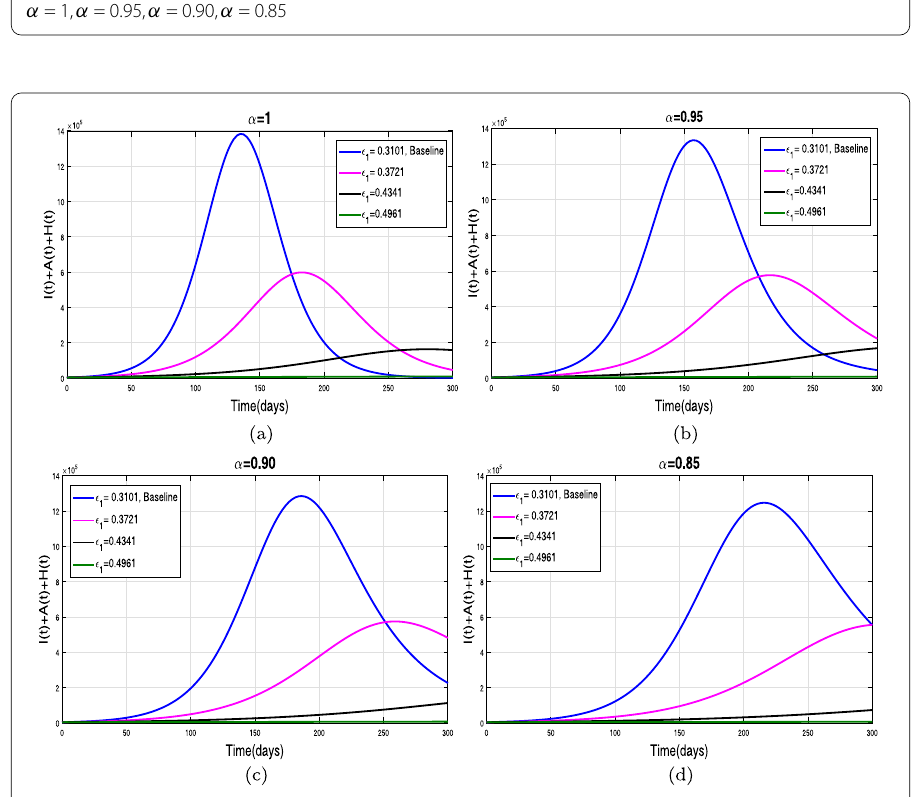
Figure 5 The influence of quarantine rate of exposed individuals ε 1 on I , A , and H individuals for α = 1, α = 0.95, α = 0.90, α =